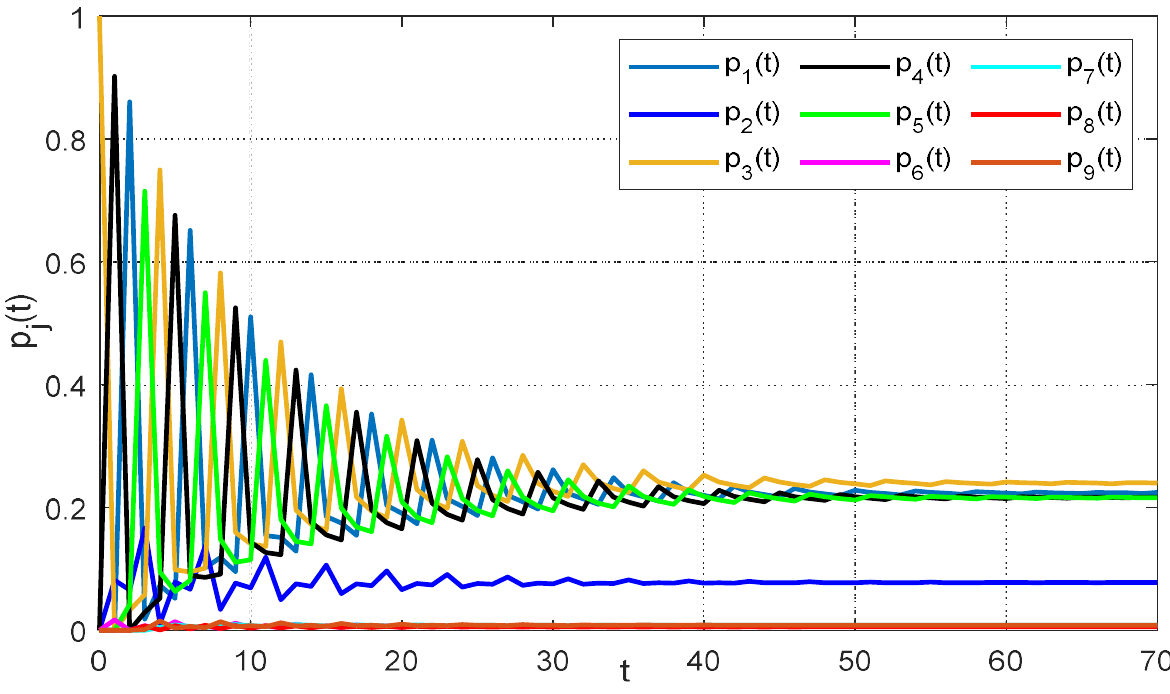
Figure 4. The course of changes in the probabilities of the states of the embedded Markov chain for